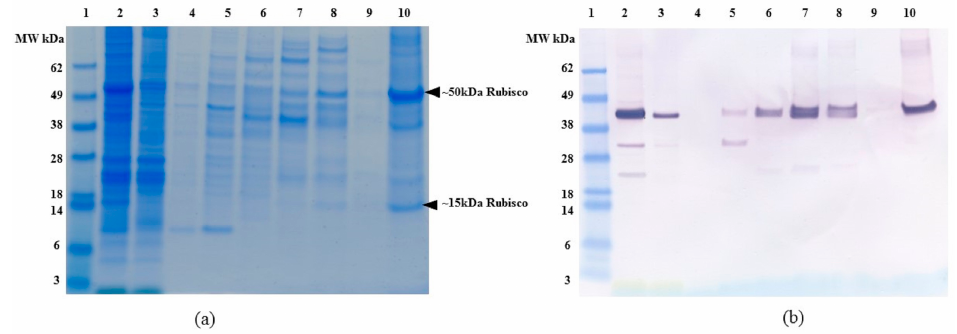
Figure 5. ( a ) SDS-PAGE and ( b ) Anti-FLAG western blot of C. reinhardtii lysate binding and elution